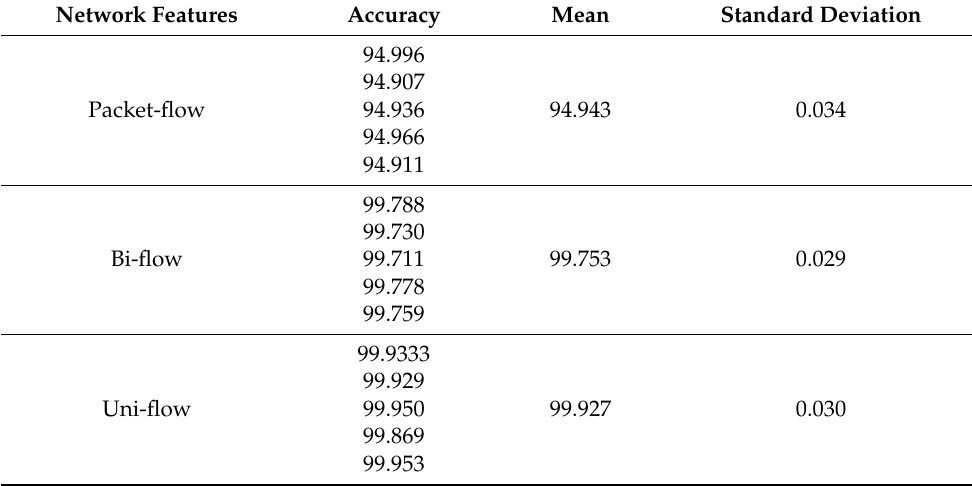
Table 9. Binary-class attack classification with five-fold cross validation results in terms of accuracy. Network